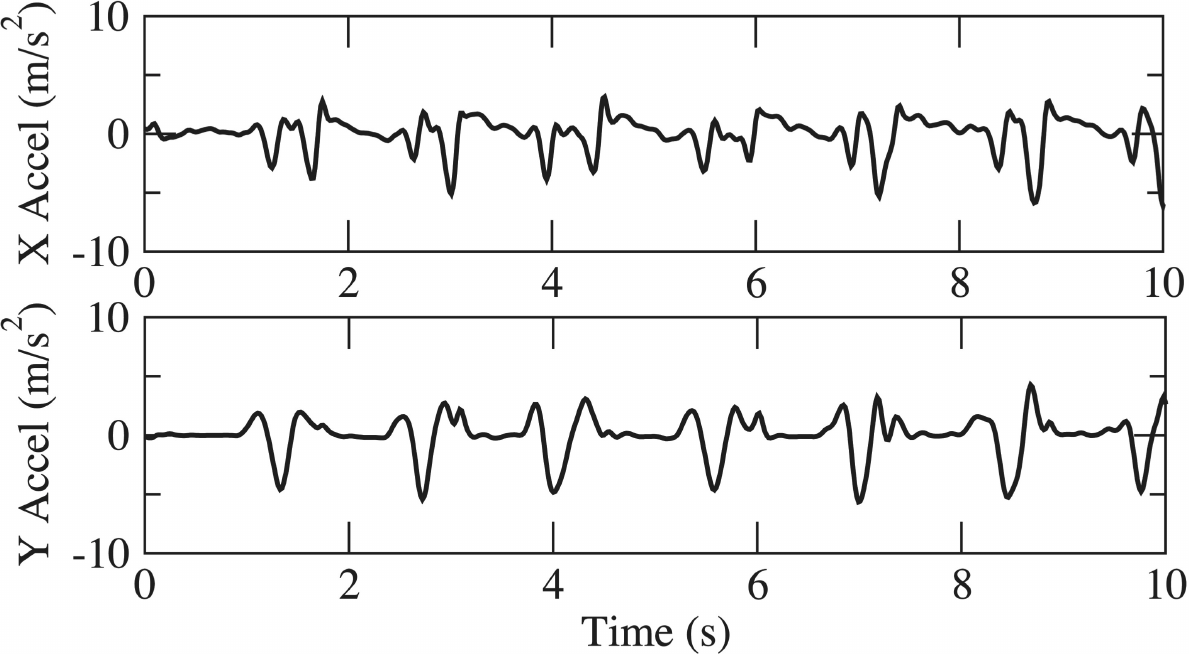
Figure 8. Acceleration in walking, Unified Parkinson’s Disease Rating Scale (UPDRS) gait score = 1.